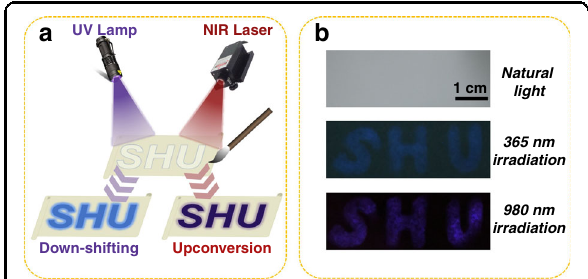
Fig. 3 The experimental scheme of dual-mode anti-counterfeiting performance of LNP:50%Tb@EuSe. a “ SHU ” pattern drawn on the non- fl uorescent paper by writing brush dipped in the fl uorescent ink with LNP:50%Tb@EuSe. b Photographs of the “ SHU ” handwriting using fl uorescent ink under the illumination of natural light, 365 nm UV lamp (80 mW cm − 2 ) and 980 nm laser (500 mW cm − 2 ),